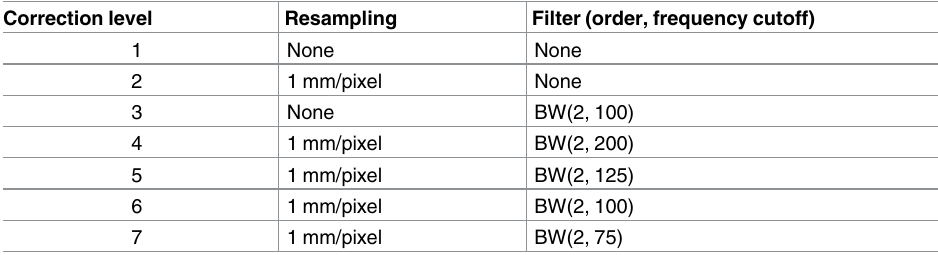
Table 1. Image correction